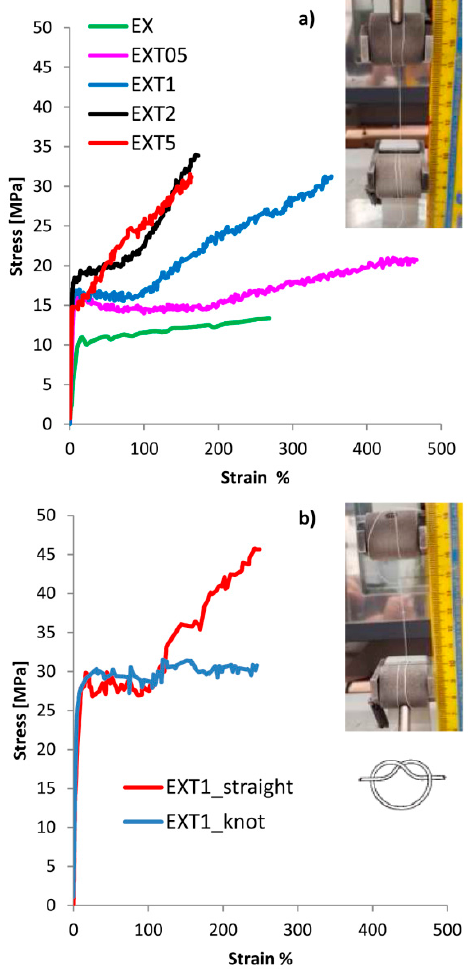
Figure 4. The representative curves of all the blends as ASTM D2256-2002 ( a ), and of the EXT1 thread in straight and in knot situations as the USP standard ( b ).